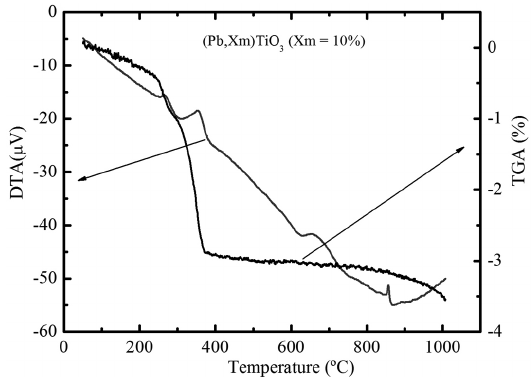
endothermic peaks, at the same temperatures, as shown in Figure 1 for PXT10. The weight loss of PXT15 shown by TGA curve is the same as PXT10. The difference between the two measurements is the amount of weight loss. For